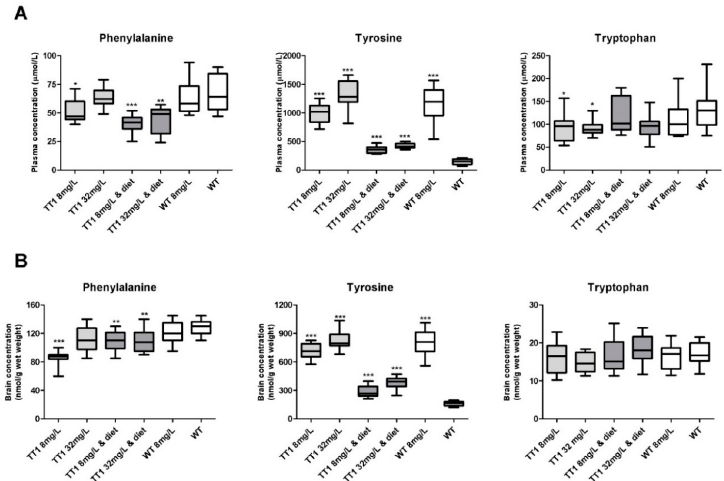
Figure 1. Plasma ( A ) and brain ( B ) phenylalanine, tyrosine and tryptophan concentrations. Untransformed data are expressed as boxplots (min–max whiskers). Numbers of mice are n = 13 or n = 14 for all treatment groups. For each large neutral amino acids (LNAA), significant differences between the different groups of mice and wild-type (WT) mice without 2-(2-nitro-4-trifluoromethylbenoyl)-1,3-cyclohexanedione (NTBC) are shown only, whereas other significant differences are explained in the main text. * p < 0.05, ** p < 0.01 and *** p < 0.001 (two-sided).